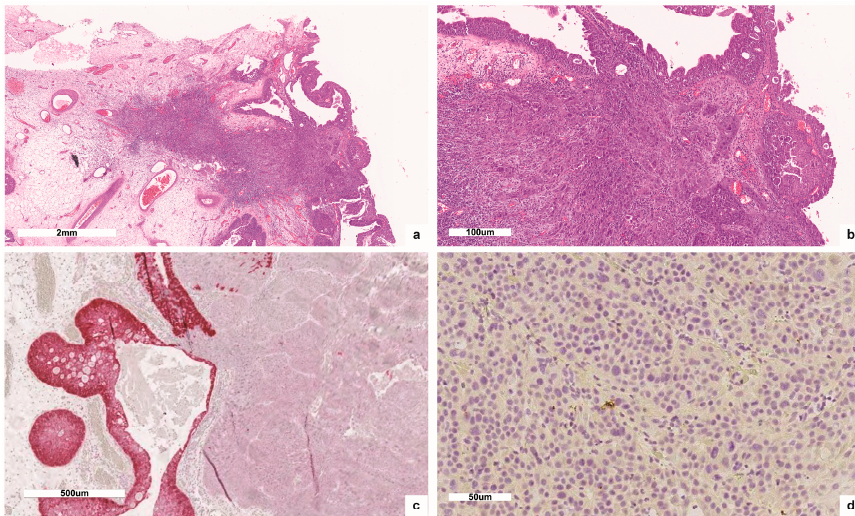
Figure 2. ( a , b ) The second described polypoid lesion showed multifocal areas of carcinoma in situ, only focally invasive (a:50×; b:100×); ( c ) IHC signal of p16INK4a (100×); ( d ) mRNA ISH assay negative for E6/E7 mRNA (200×).